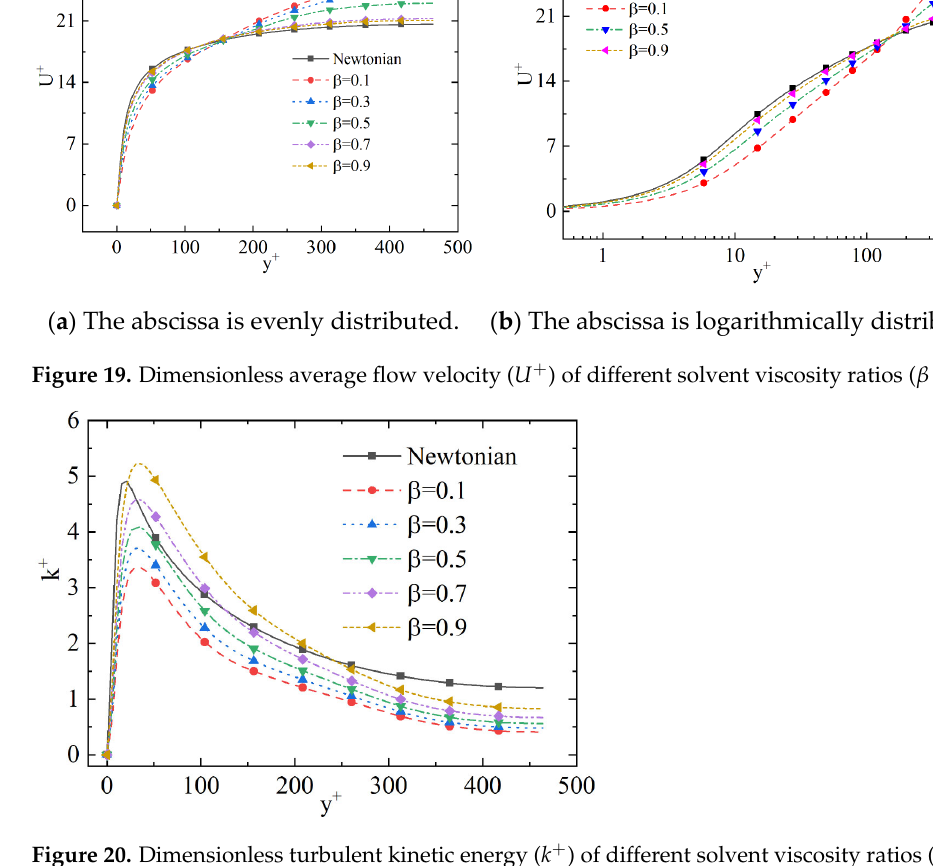
U  ) of different solvent viscosity ratios (  ).